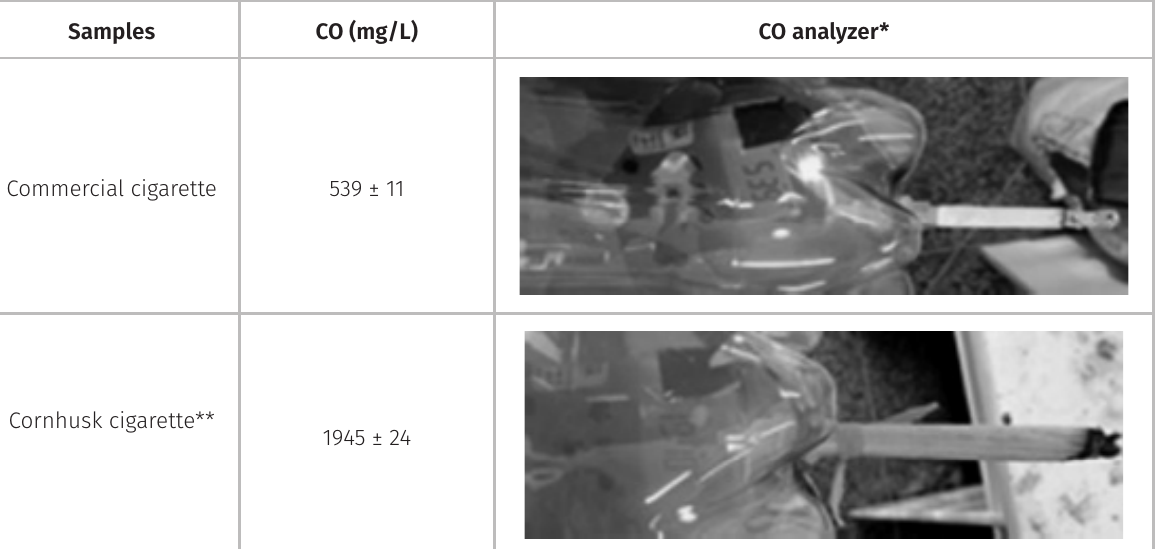
Table III. Presence of carbon